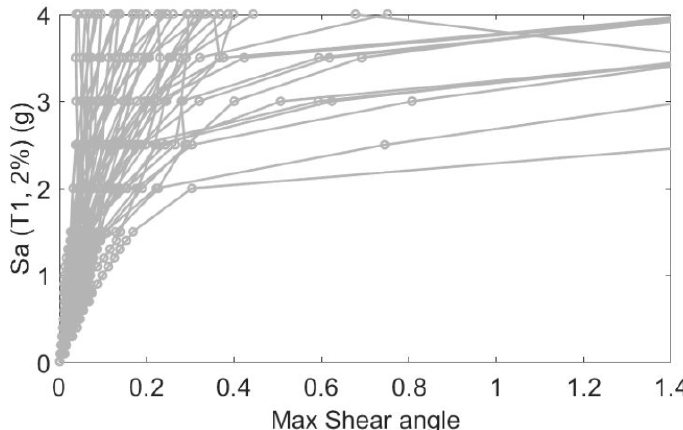
Figure 10. Incremental dynamic analysis for a butterfly-shaped fuse system.